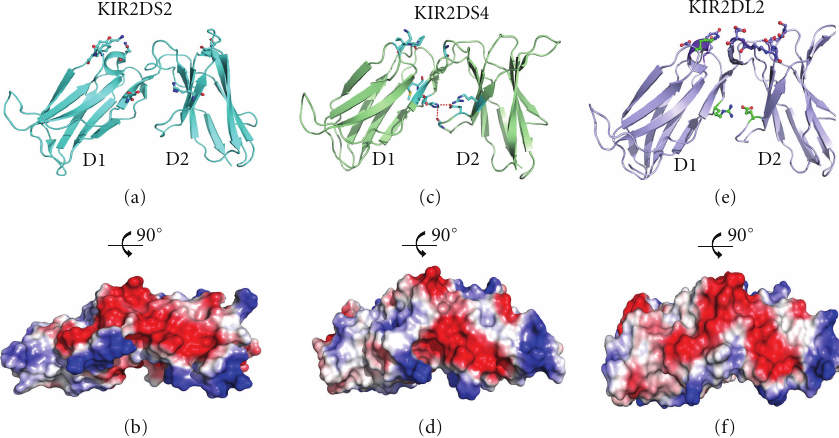
Figure 3: Structure of activating KIR receptors. (a) KIR2DS2 shown in cartoon representation with residues likely important for ligand binding and also the hinge region residues shown in ball and stick representation. (b) Charged surface representation of the membrane distal face (binding face) of KIR2DS2. (c) KIR2DS4 shown in cartoon representation with ligand binding and hinge region residues shown in ball and stick representation. (d) Charged surface representation of the membrane distal face (binding face) of KIR2DS4. (e) For comparative purposes, the inhibitory receptor KIR2DL2 is shown in cartoon representation with ligand binding and hinge region residues shown in ball and stick representation. (f) Charged surface representation of the membrane distal face (binding face) of the inhibitory receptor